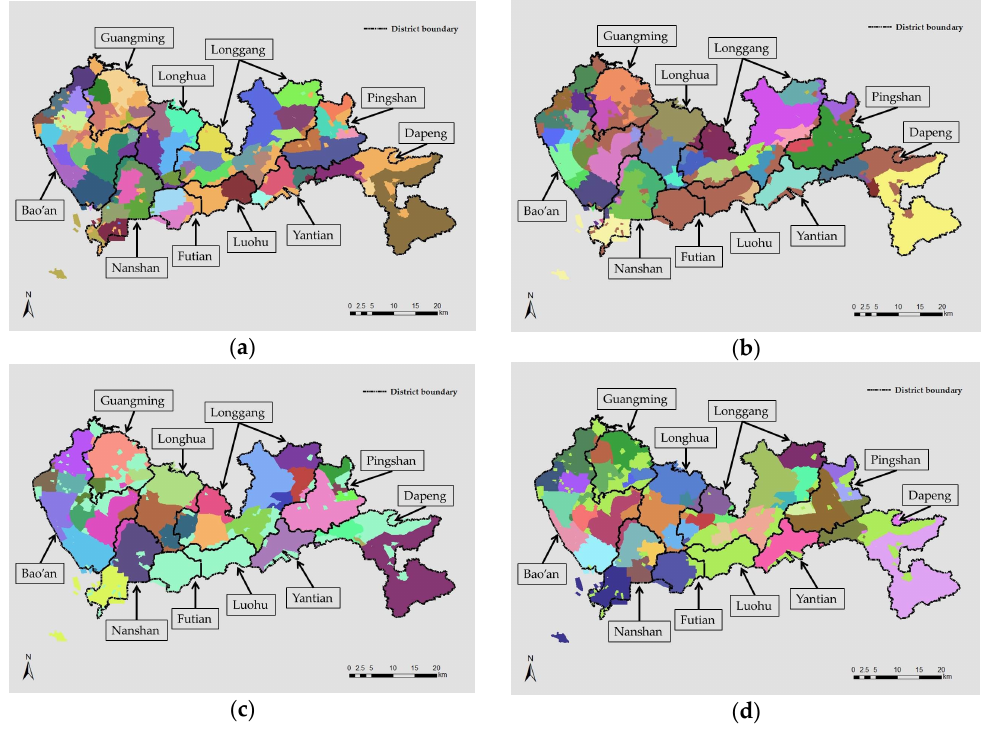
Figure 7. Interaction-based structures during: ( a ) 4:00–5:00 a.m.; ( b ) 5:00–6:00 a.m.; ( c ) 6:00–7:00 p.m.; and ( d ) 7:00–8:00